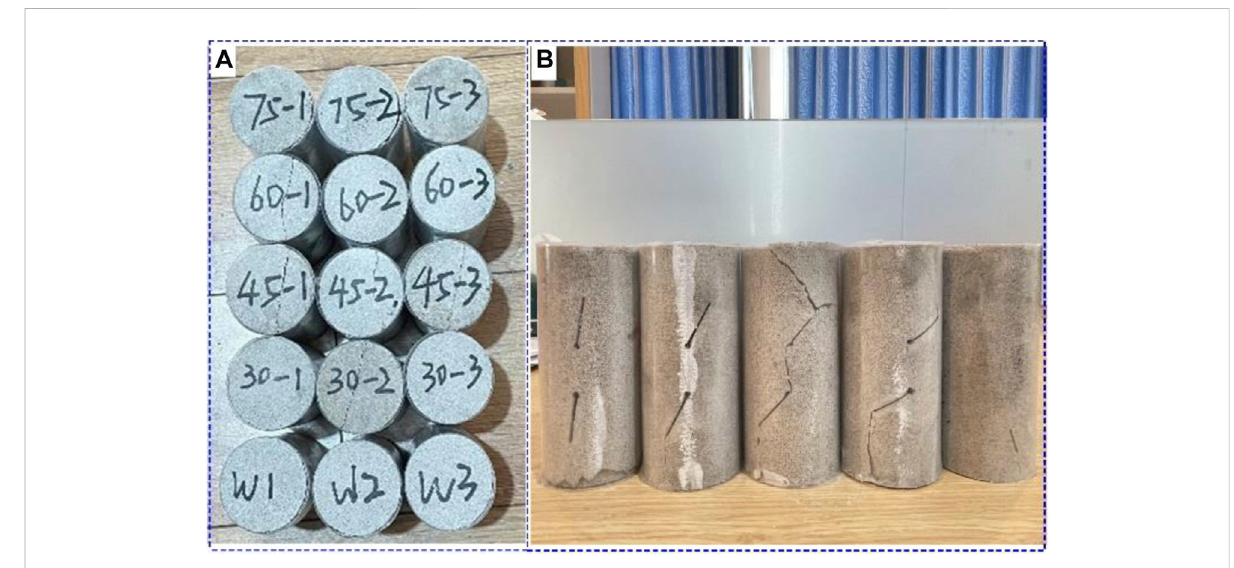
FIGURE 1 Test rock samples. (A) specimen number and (B) rock fracture pattern.